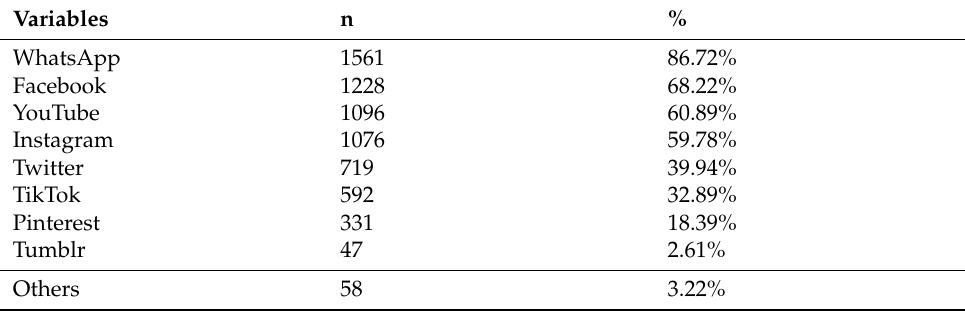
Table 6. The most social networks used by respondents.